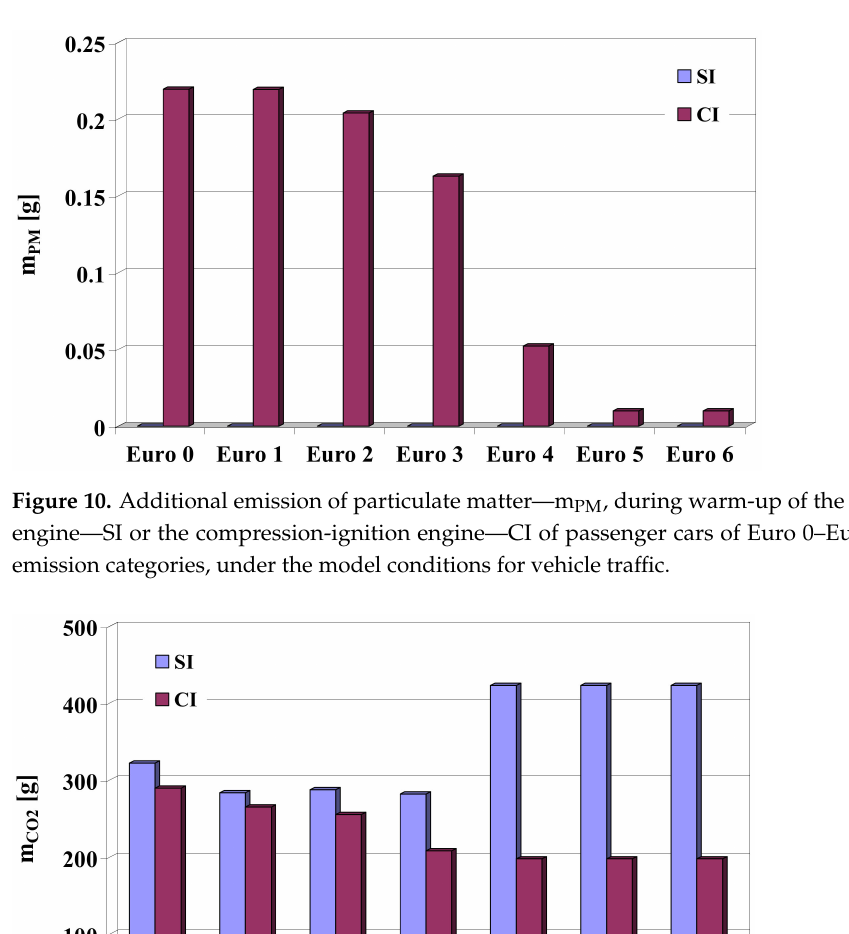
Figure 9. Additional emission of nitrogen oxides—m NOx , during warm-up of the spark-ignition engine—SI or the compression-ignition engine—CI of passenger cars of Euro 0–Euro 6 pollutant emission categories, under the model conditions for vehicle traffic.